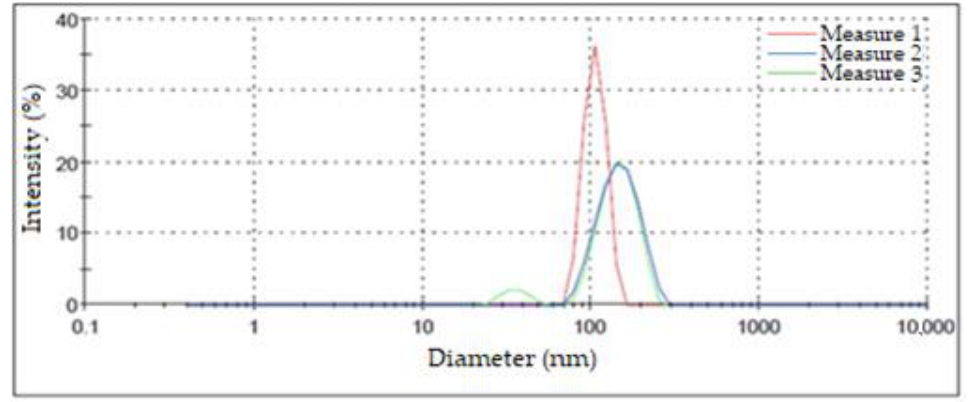
Figure 8. Particle size distribution according to DLS.